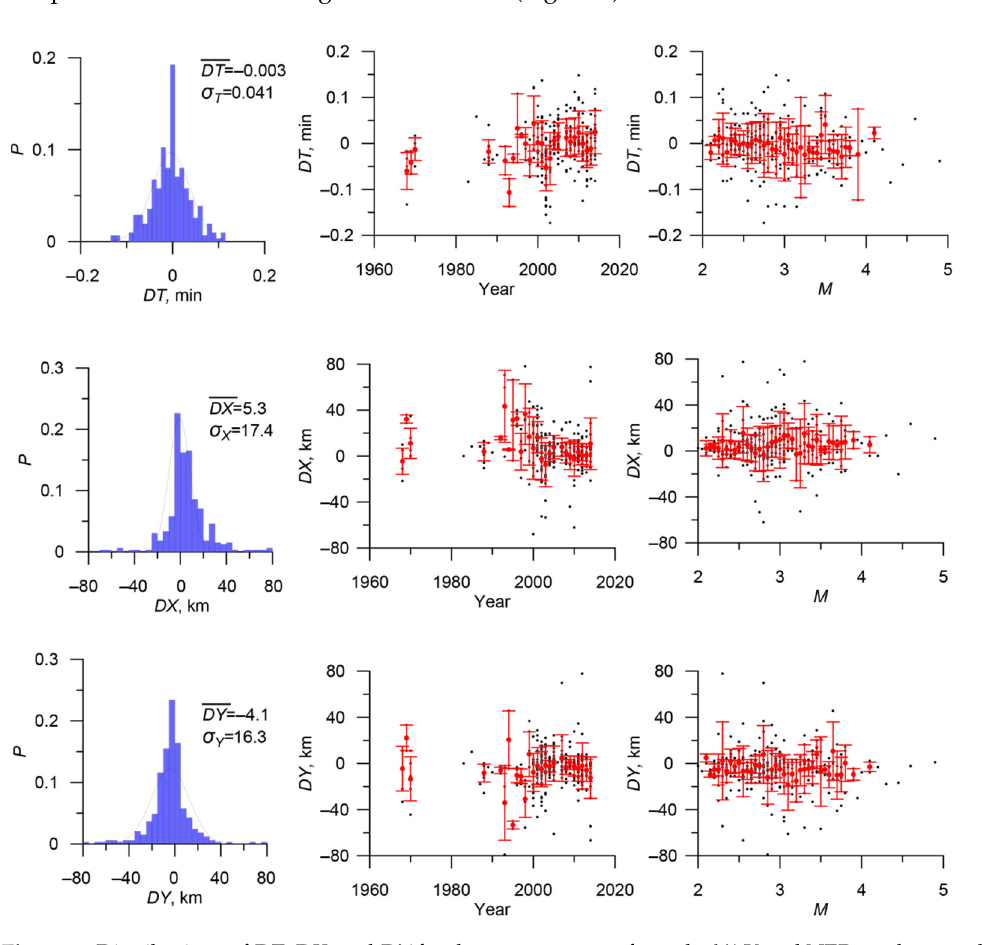
Figure 2. Distribution of metric (1) for events within the source catalogs (Tables 1 and 2). The cata- logs are indicated on the histograms.